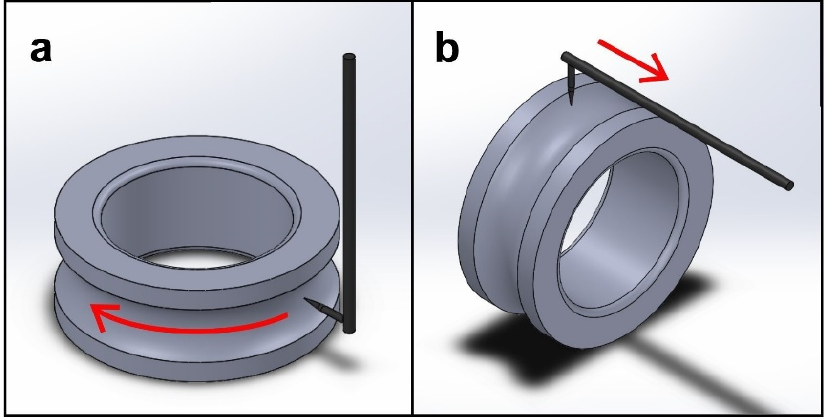
Figure 2. Methods of measuring the waviness of the rolling bearing race surface: ( a ) along the cir- cumference of the race (Talyrond 365), ( b ) across the circumference of the race (Talysurf PGI).